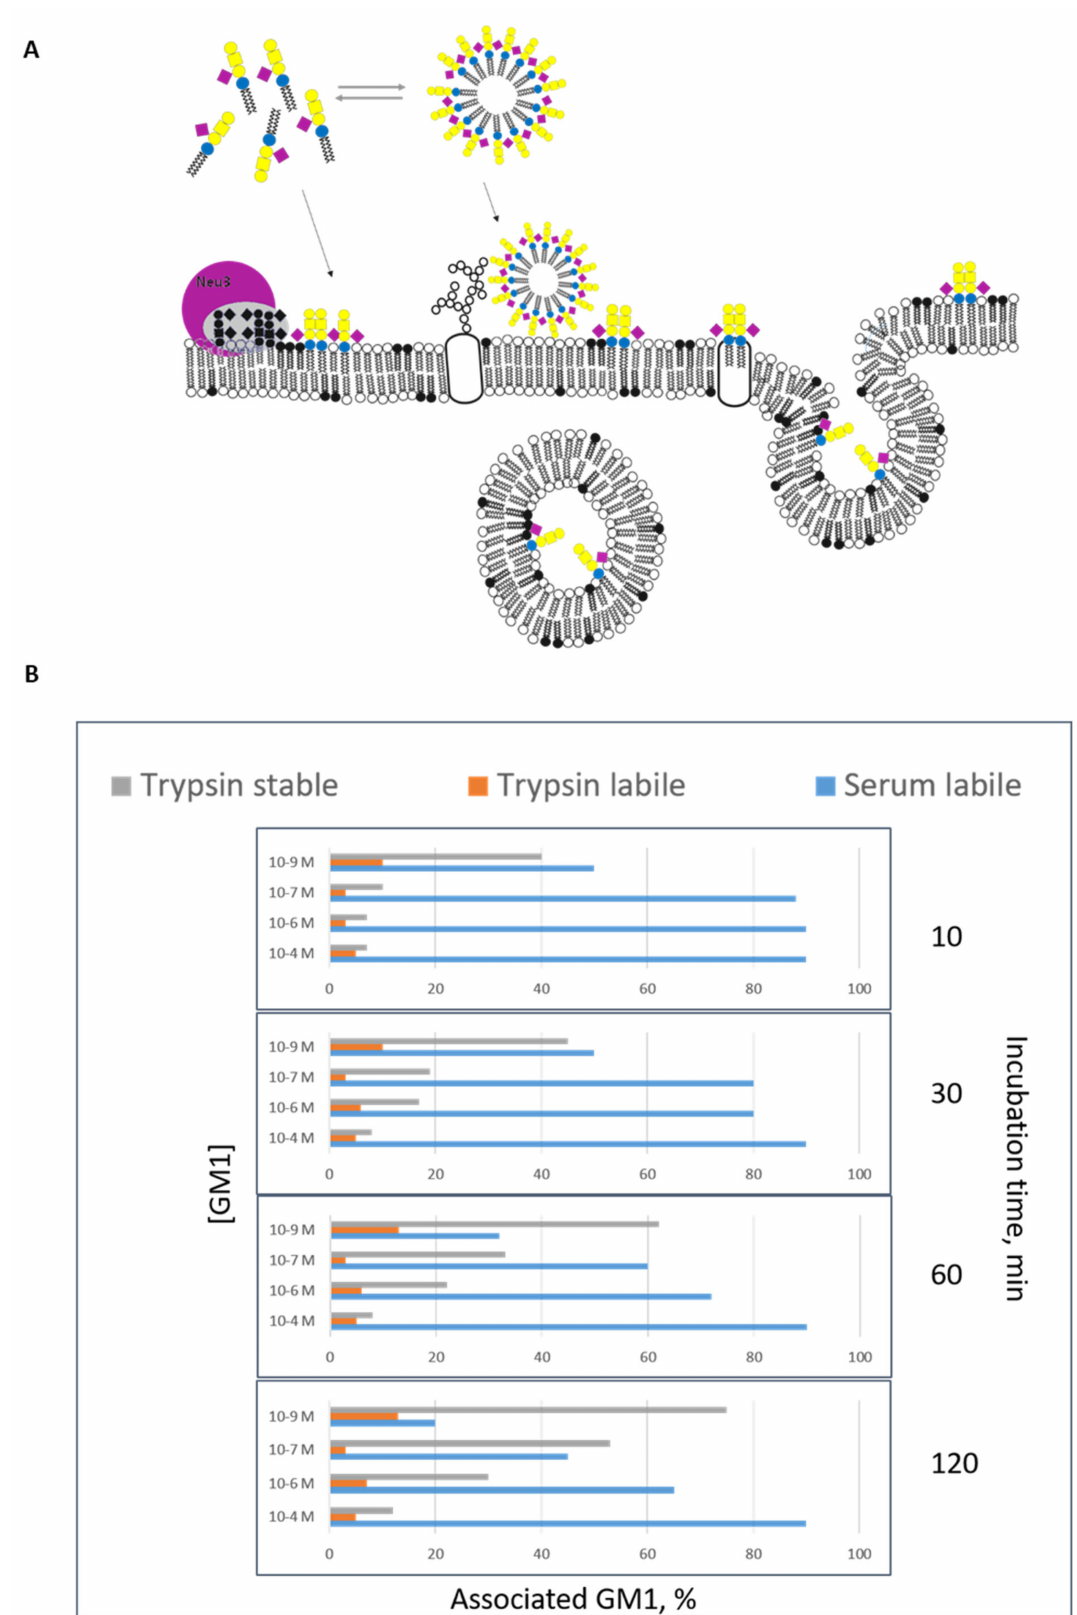
Figure 4. Association of exogenous administered GM1 to cell culture. Ganglioside occurs in water solution in two physical forms, as monomers and micelle. Below a certain